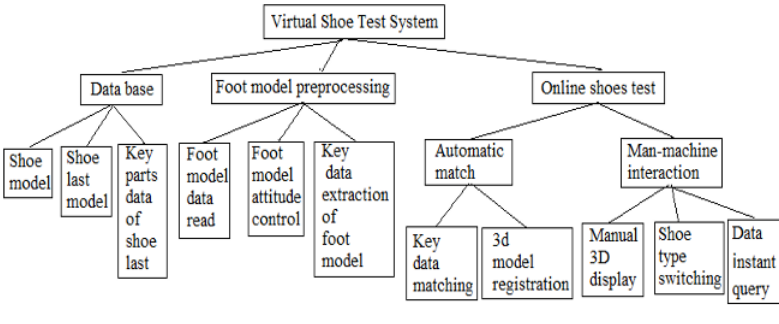
Fig. 1. System module